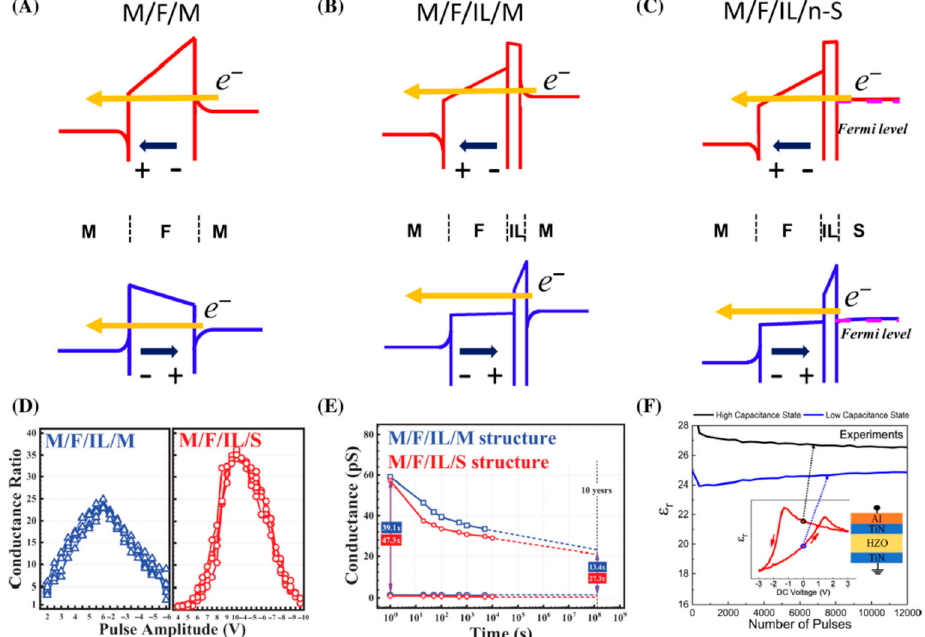
Figure 7. Energy band landscapes for different structures with different ferroelectric polarization states within the structure. ( A ) Metal/ferroelectric/metal (M/F/M), ( B ) metal/ferroelectric/interlayer/metal (M/F/IL/M), and ( C ) metal/ferroelectric/IL/semiconductor (M/F/IL/S) structures. The band structures are drawn using band diagram program with schematic Thomas–Fermi screening length of metals [114,115]. The interlayers of M/F/IL/M and M/F/IL/S are set as Al 2 O 3 and SiO 2 , respectively. ( D ) Conductance ratio of FTJs, having a TiN/Hf 0.5 Zr 0.5 O 2 (HZO)/ZrO 2 /TiN (M/F/IL/M) and TiN/HZO/ZrO 2 /poly-Si (M/F/IL/S) structure as a function of the pulse amplitude. ( E ) Retention characteristics of M/F/IL/M and M/F/IL/S FTJs; both devices were measured after wake-up field cycling of 10 6 cycles with ±6 V/500 ns and 10 V/500 ns for M/F/IL/M and M/F/IL/S, respectively. ( F ) Relative permittivity of a M/F/M capacitor as a function of the field cycles. The inset shows the device schematic (right) and a hysteresis loop of the relative permittiv- ity (left). The relative permittivity was extracted from the small-signal capacitance measured at 0 V with a bias amplitude of 30 mV. The program/erase pulse amplitude used were 3 V/ − 3 V. ( D , E ) Reproduced with permission [105]. Copyright 2021, IEEE. ( F ) Reproduced with permission [116]. Copyright 2021, IEEE.